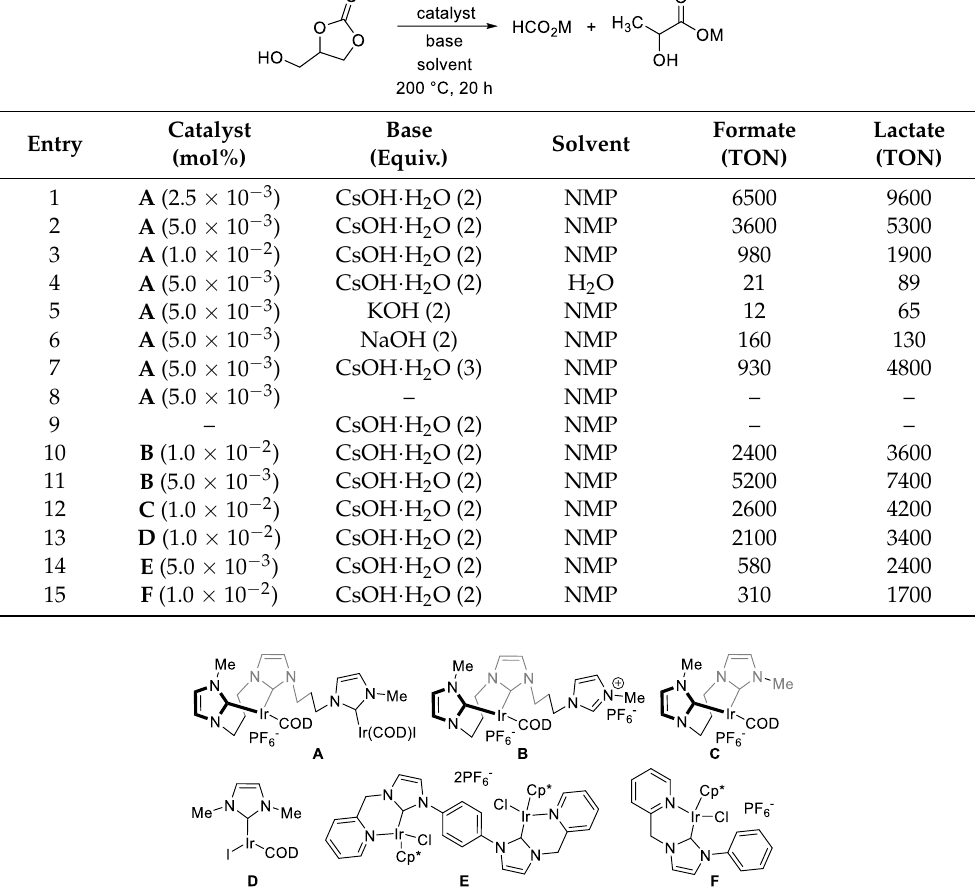
Table 1. Transfer hydrogenation of GC.